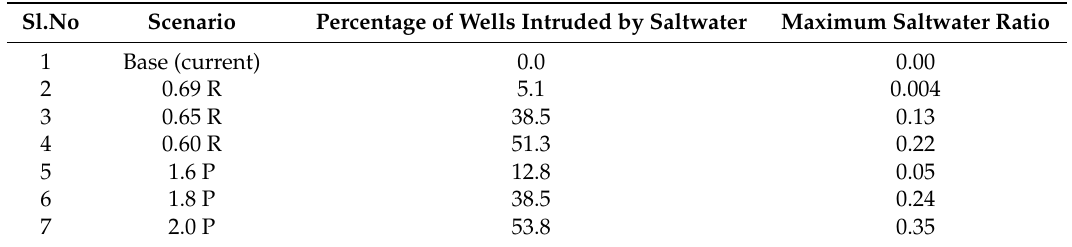
Table 4. Well salinization under different scenarios.